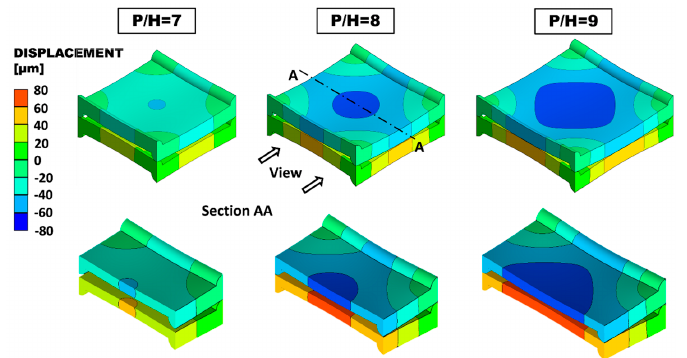
Figure 2. Deformation of membranes with di ff erent P / H ratios under TMP = + 0.8 bar. The quantity shown is the displacement in the direction orthogonal to the undeformed membranes ( y ). Top: external external view; bottom: view after sectioning by a mid-plane A-A. view; bottom: view after sectioning by a mid-plane